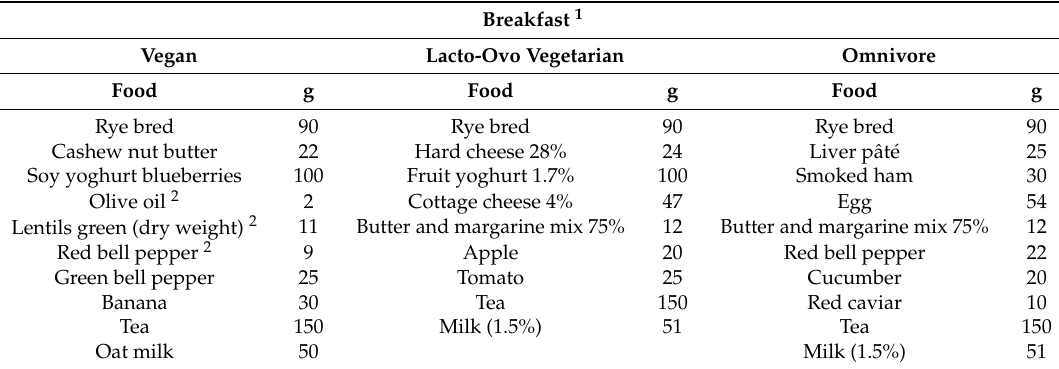
Table 2. Meal composition of breakfast